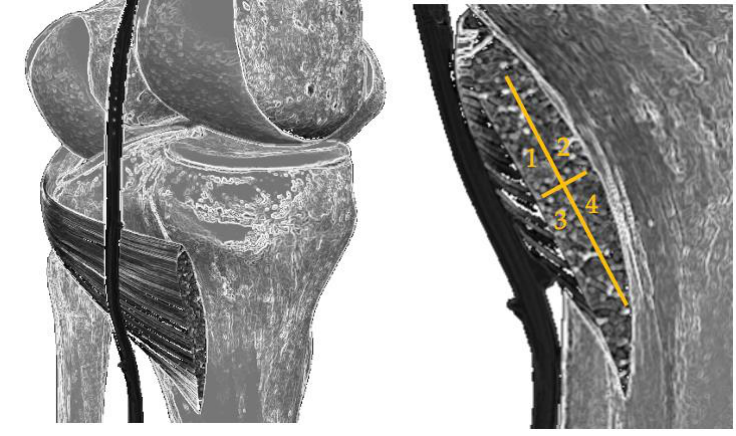
Figure 1. Diagram of the division of the popliteus into four